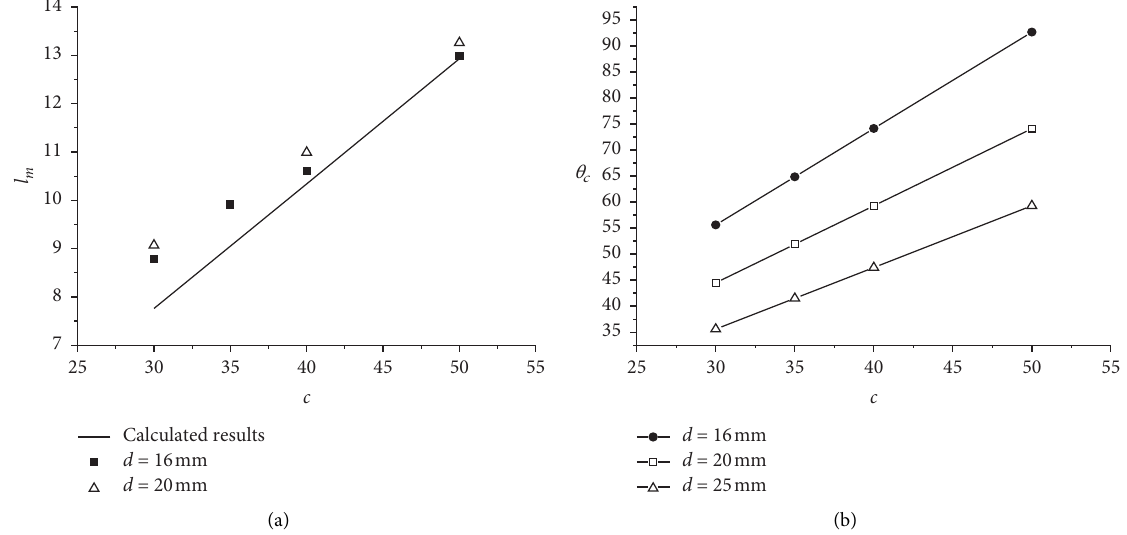
Figure 8: The relationship between concrete cover and the concrete crack spacing [18]. (a) Calculating and measuring crack spacing ( d � 16mm and 20mm). (b) Calculation results of crack spacing of concrete with different diameters of reinforcing bars.